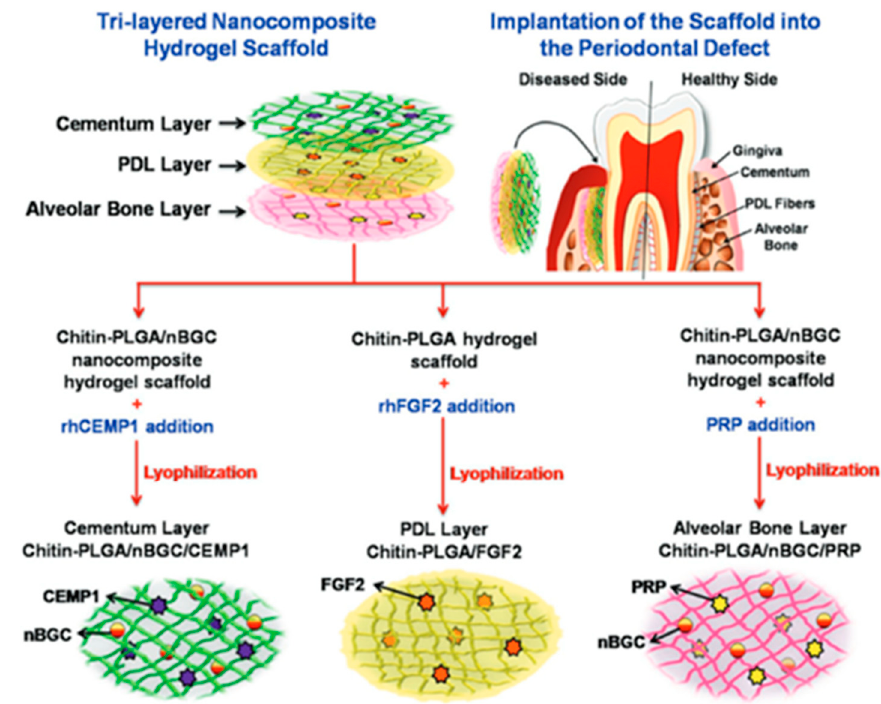
Figure 3. Trilayered nanocomposite hydrogel scaffold for periodontal regeneration. “Reprinted (adapted) with permission from Sowmya, S.; Mony, U.; Jayachandran, P.; Reshma, S.; Kumar, R.A.; Arzate, H.; Nair, S.V.; Jayakumar, R. Tri-Layered Nanocomposite Hydrogel Scaffold for the Con- current Regeneration of Cementum, Periodontal Ligament and Alveolar Bone. Adv. Healthc. Mater . 2017 , 6 . https://doi.org/10.1002/adhm.201601251. Copyright 2017 WILEY-VCH Verlag GmbH & Co. KGaA, Weinheim .